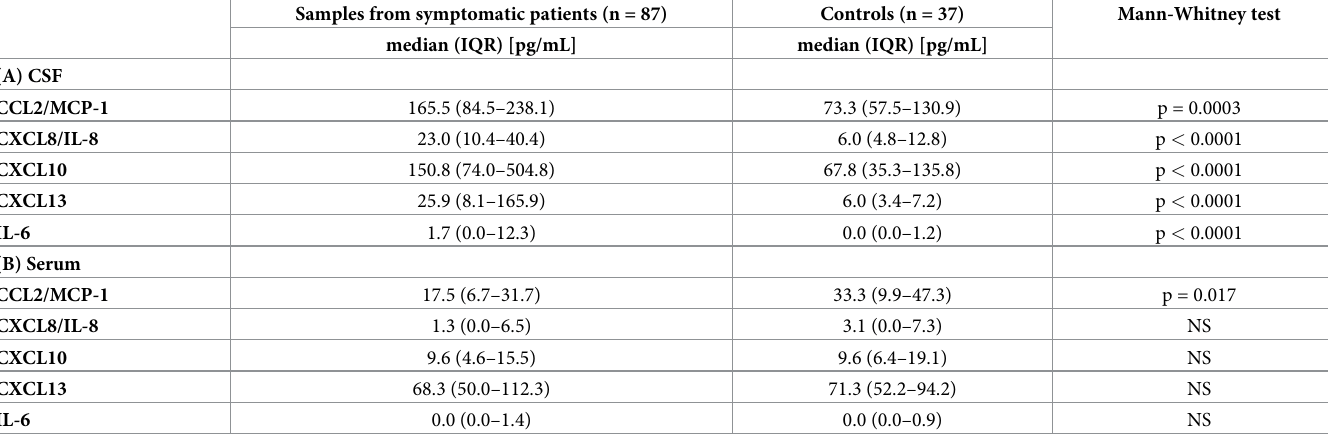
Table 2. Chemo/Cytokine levels in symptomatic inflammatory samples and controls.